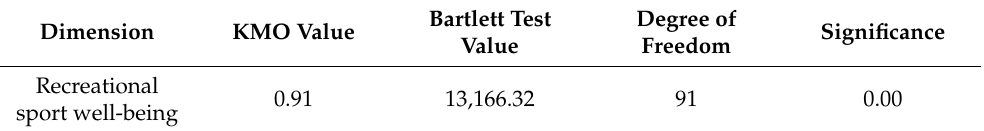
Table 2. Kaiser–Meyer–Olkin Test Analysis.